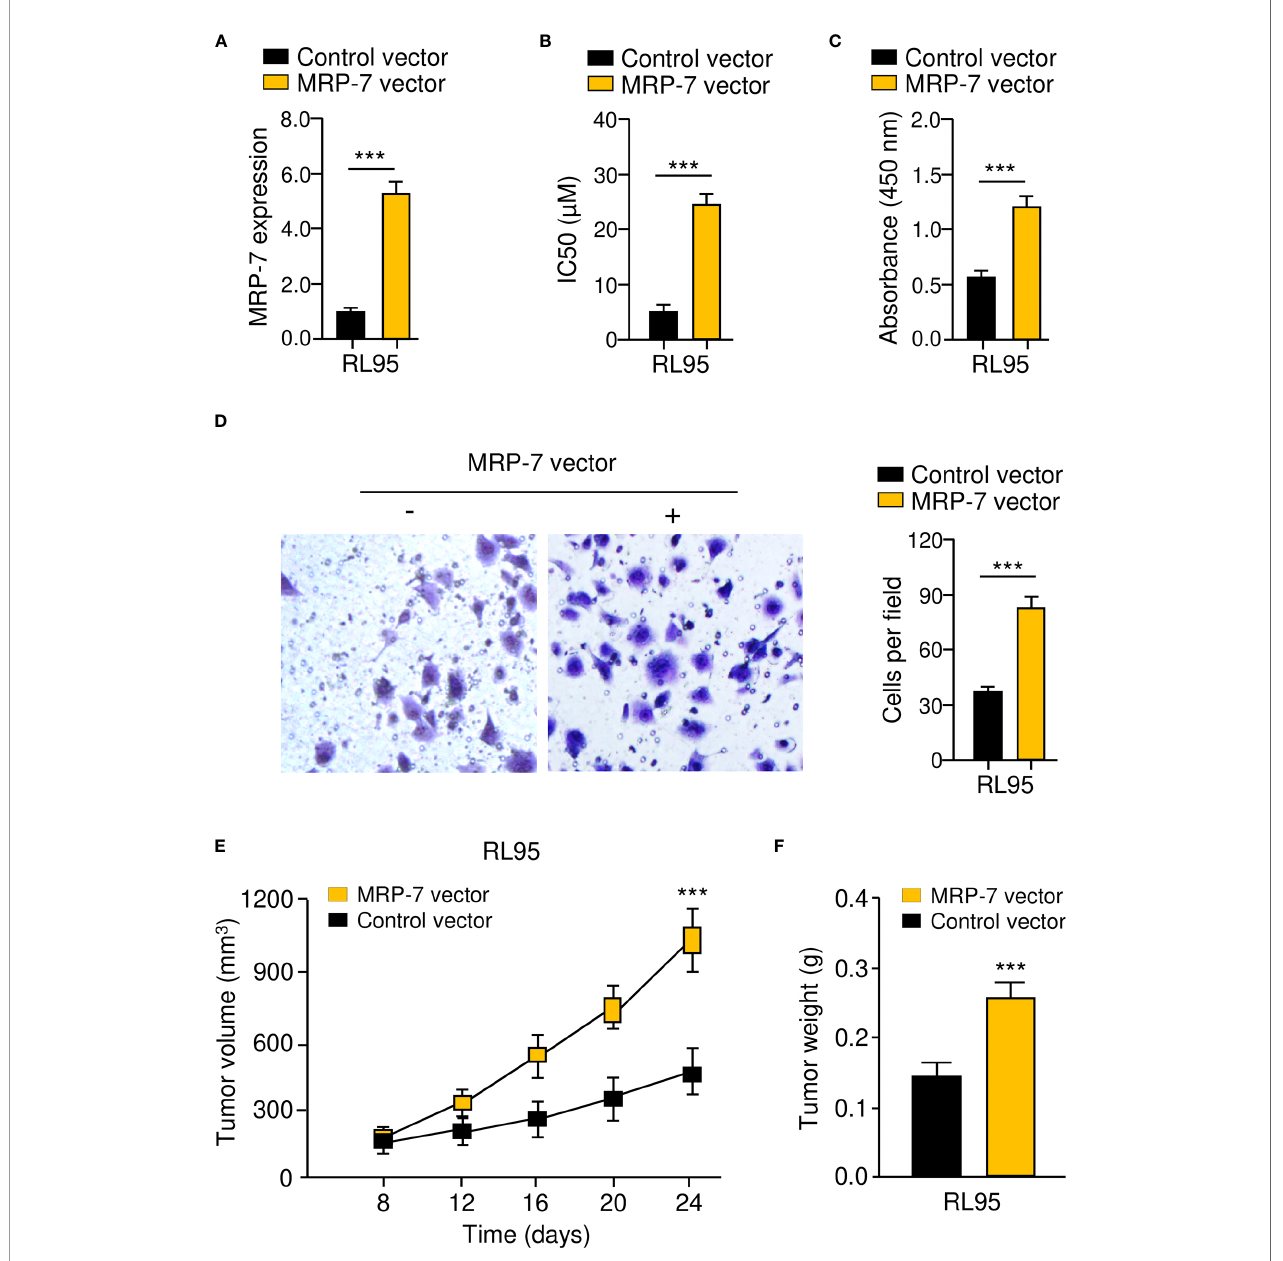
FIGURE 4 | MRP-7 Enhances Paclitaxel Resistance and Aggressive Phenotypes of EC Cells. (A) MRP-7 expression in MRP-7-expressing RL95 cells and control cells. (B – D) The IC50 values for paclitaxel (B) , cell proliferation (C) , and invasion (D) were examined in MRP-7-expressing RL95 cells and control cells. (E, F) Nude mice were injected subcutaneously with MRP-7-expressing RL95 cells or control cells. The tumor volume (left) and tumor weight (right) were displayed. *** P <